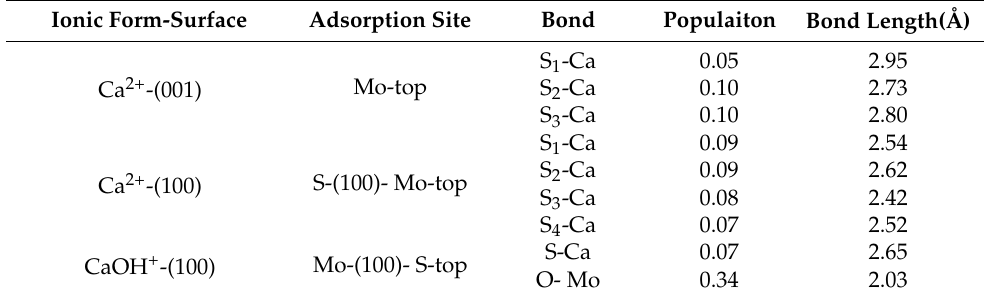
Table 4. Mulliken population and bond length of the stable adsorption configurations. Ionic